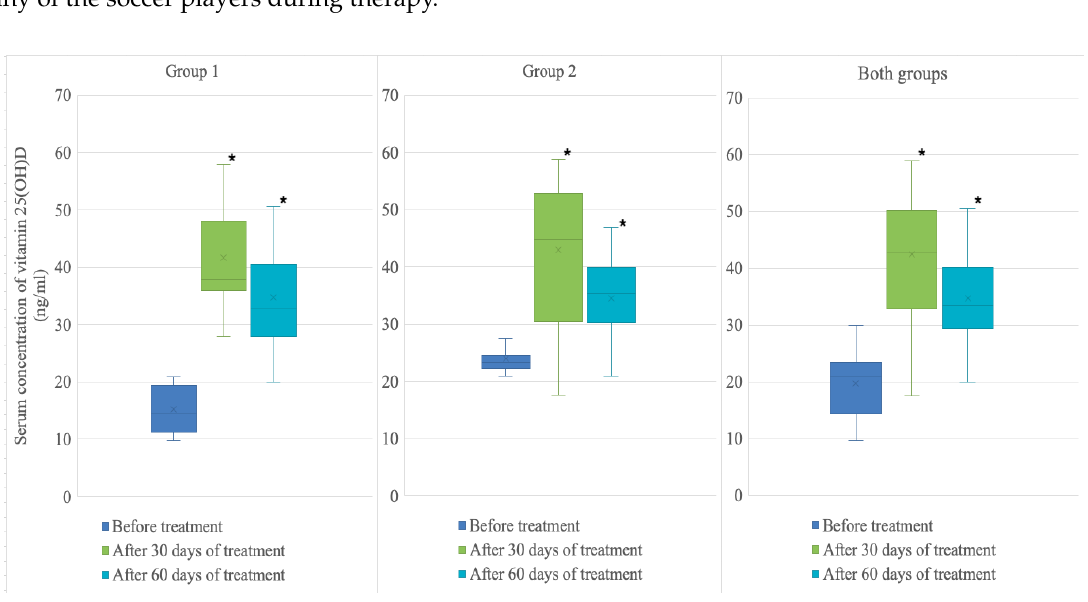
Figure 2. Serum concentration of vitamin 25(OH)D (ng/mL) before treatment and after 30 and 60 days of treatment in Group 1, Group 2 and both groups combined.